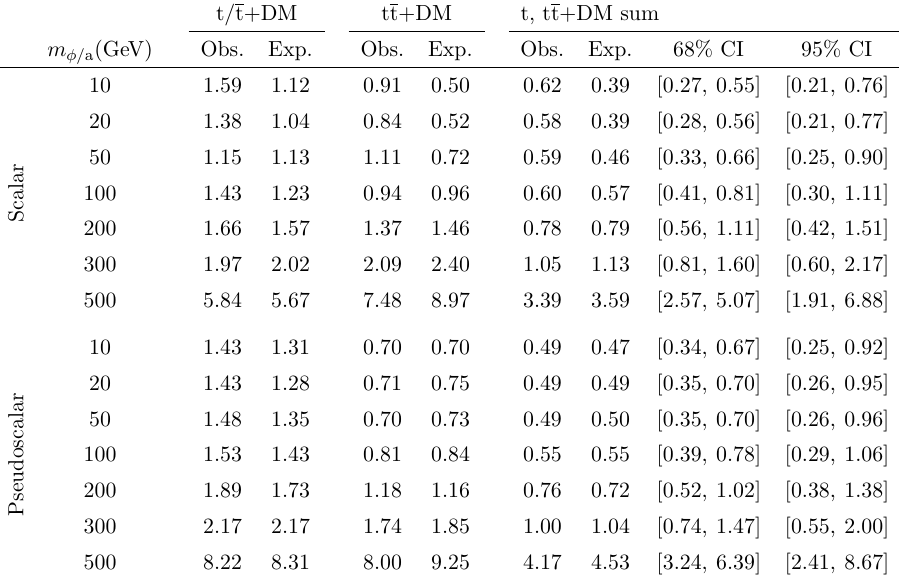
Table 3 . Upper limits at 95% CL on the cross section ratio with respect to the expected DM signal for di(cid:11)erent scalar ( (cid:30) ) or pseudoscalar (a) mediator masses, m (cid:31) = 1 GeV, and g (cid:31) = g q = 1 for the combination of SL and AH signal regions. The median expected value and its 68 and 95% con(cid:12)dence intervals (CIs) are given. Table 3 represents the (cid:12)nal combined limits (SL + AH) for the t = t+DM and tt+DM processes separately, and for the sum of the two processes. Overall, we exclude mediator masses below 290 and 300 GeV for the scalar and pseu- doscalar hypotheses,